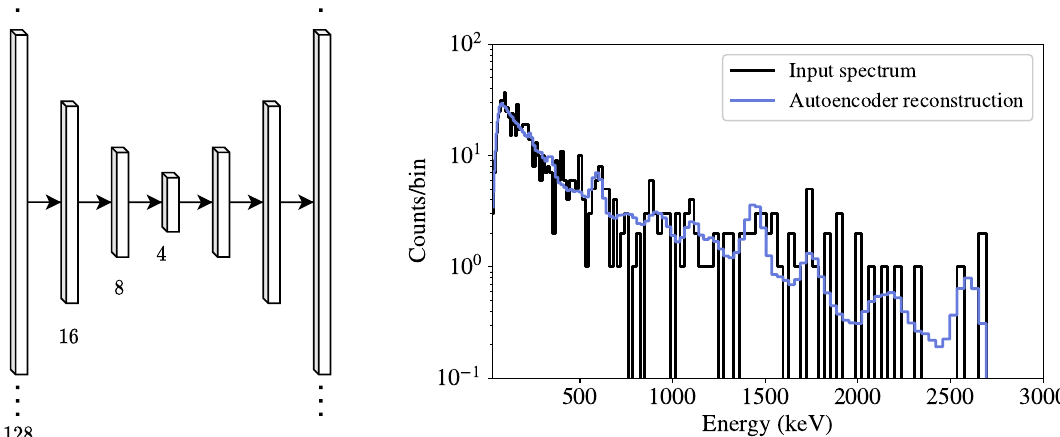
Figure 1. ( Left panel ) Diagram showing the dimensionality of features h ( i ) at each layer i for an example dense autoencoder architecture with five hidden layers. A 128-bin spectrum is input into the autoencoder, and dense layers are computed by performing nonlinear transformations on each preceding layer. The inverse of each operation is then performed to decode the latent features, resulting in a smoothened spectrum. ( Right panel ) An input background spectrum x and corresponding autoencoder reconstruction ˆ x are shown. When trained on background, the autoencoder learns spectral features such as background peaks and the associated downscattering continuum. Both the input and output spectra shown here contain 128 bins with widths that scale with the square root of energy. Note that any apparent deviations between the input and output spectra (e.g., at the 1460 keV peak) are due to low-statistics, as the bins of the measured spectrum x are discrete random samples of the mean Poisson rate ˆ x